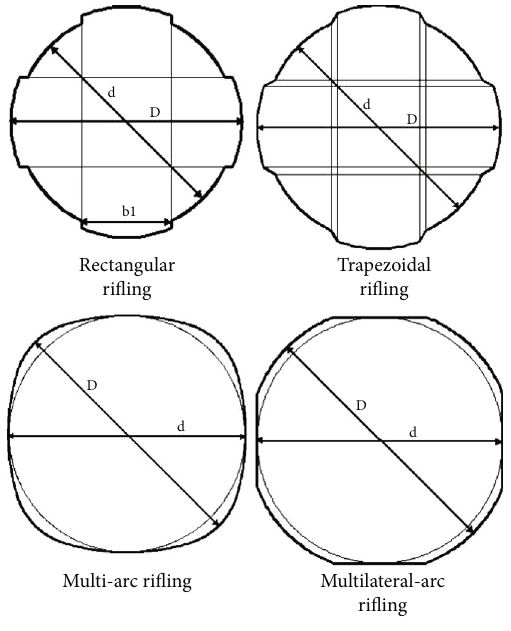
Figure 1: Cross-sectional pro fi les of ri fl ed